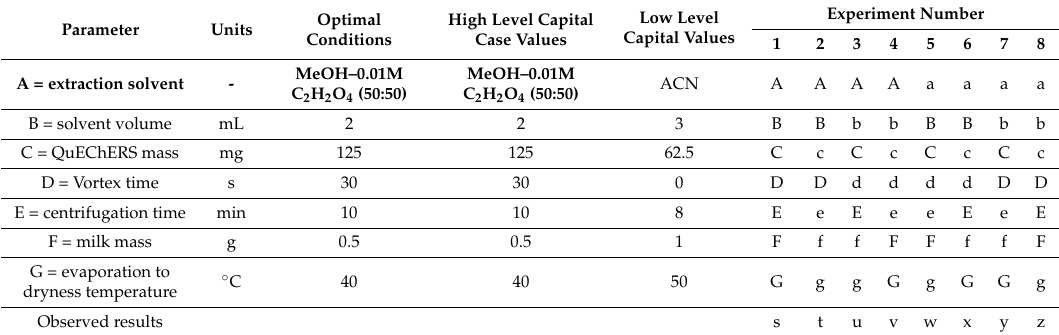
Table 2. Youden’s ruggedness test by applying seven deliberate changes in the operating parameters.